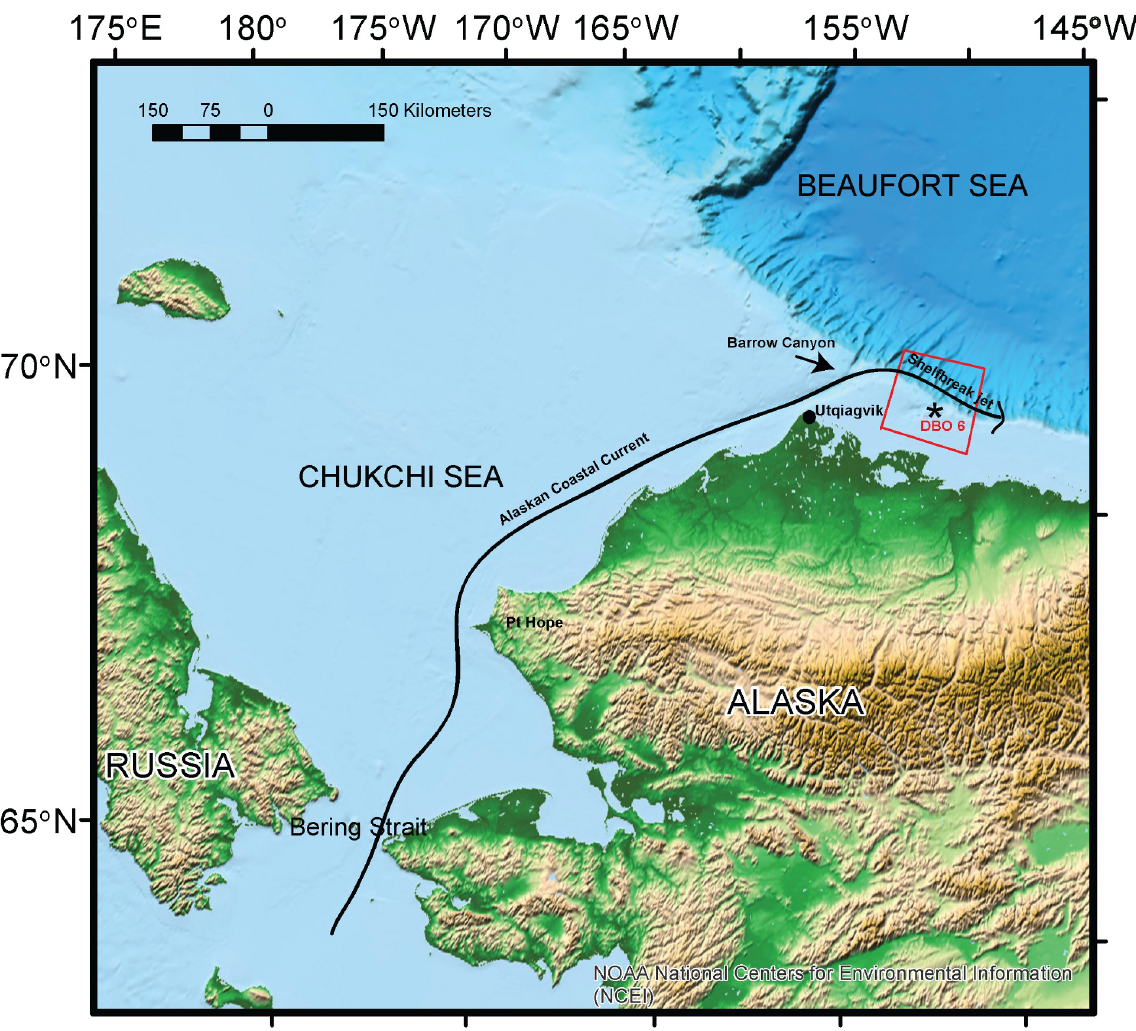
Fig 1. Map of study area. DBO 6 boundaries shown as red box, the mooring location as an asterix and the Alaskan Coastal Current and its extension, the Beaufort shelfbreak jet shown as a black line.